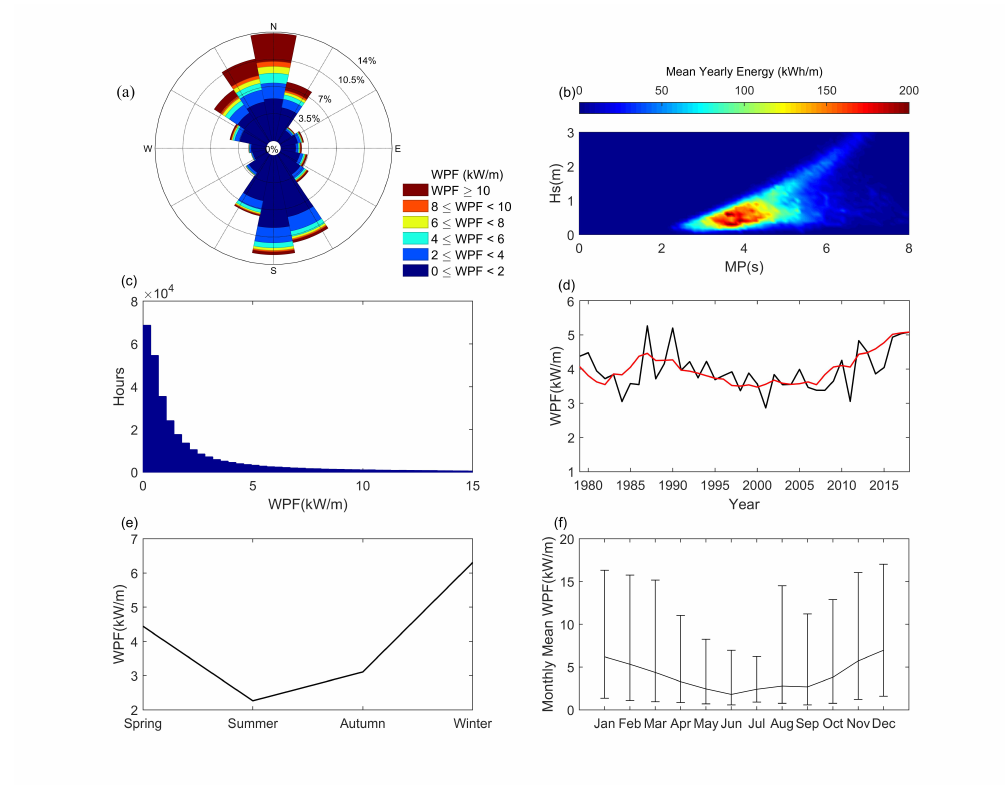
Figure 13. Wave energy assessment for A1. (( a ) The wave power rose; ( b ) the wave power matrix; ( c ) persistence of the wave power in hours; ( d ) black line: yearly mean wave power, red line: 5 years mean wave power; ( e ) seasonal mean wave power; ( f ) monthly mean wave